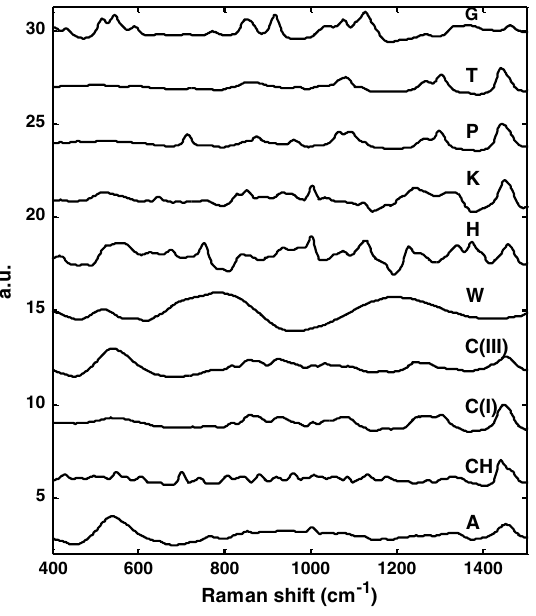
Fig. 2. Raman spectra of the 10 components used in the simulation: (A): actin; (CH): cholesterol; (CI): collagen I; (CIII): collagen III; (W): water; (H): hemoglobin; (K): keratin; (P): phosphatidylcholine; (T): triolein; (G):